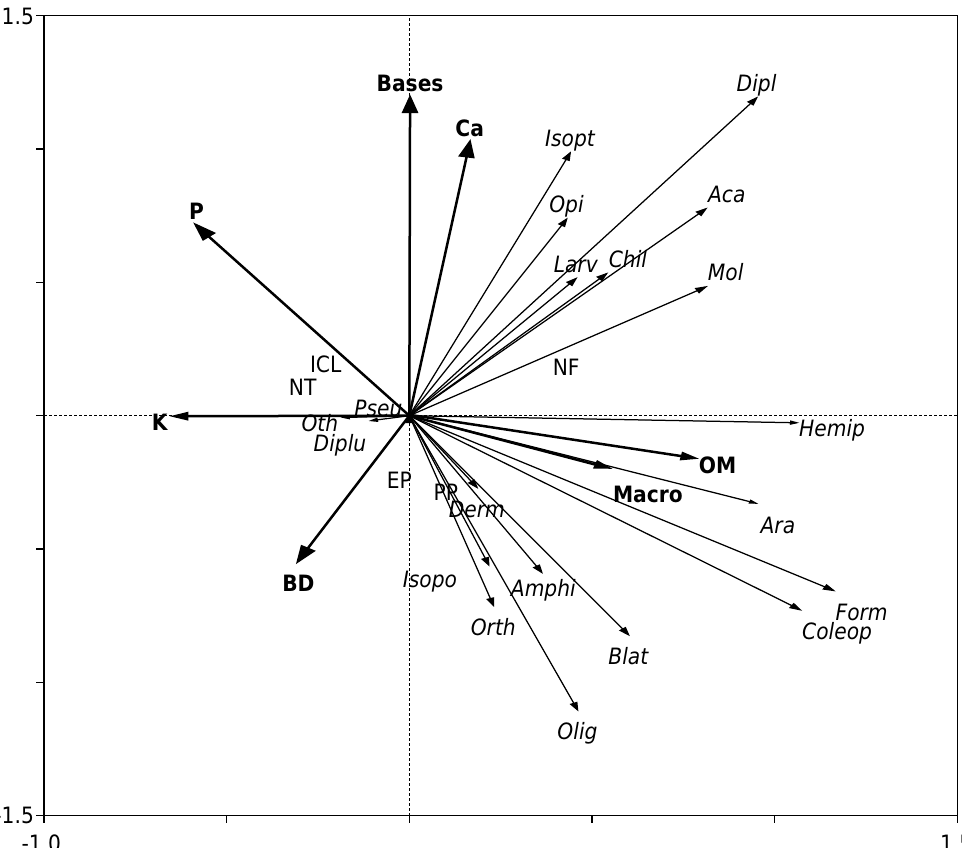
Figure 5. Principal component analysis (PCA) to differentiate native forest (NF), eucalyptus plantations (EP), perennial pasture (PP), integrated crop-livestock (ICL), and no-tillage systems (NT) based on samples collected in the summer, in the eastern region of Santa Catarina, Brazil. Vectors in bold represent the soil physical (BD: bulk density, Macro: macroporosity) and chemical properties (Ca: calcium, K: potassium, P: phosphorus, Bases: base saturation, OM: organic matter). In italics are the main macrofaunal groups: Oligochaeta ( Olig ), Opiliones ( Opi ), Formicidae ( Form ), Amphipoda ( Amphi ), Coleoptera ( Coleop ), total of other larvae ( Larv ), Molusca ( Mol ), Diplopoda ( Dipl ), Chilopoda ( Chil ), Isopoda ( Isopo ), Araneae ( Ara ), Isoptera ( Isopt ), Orthoptera ( Orth ), Hemiptera ( Hemip ), Dermaptera ( Derm ), Pseudoscorpionidae ( Pseu ), Diplura ( Diplu ), and total of other less frequent groups ( Oth